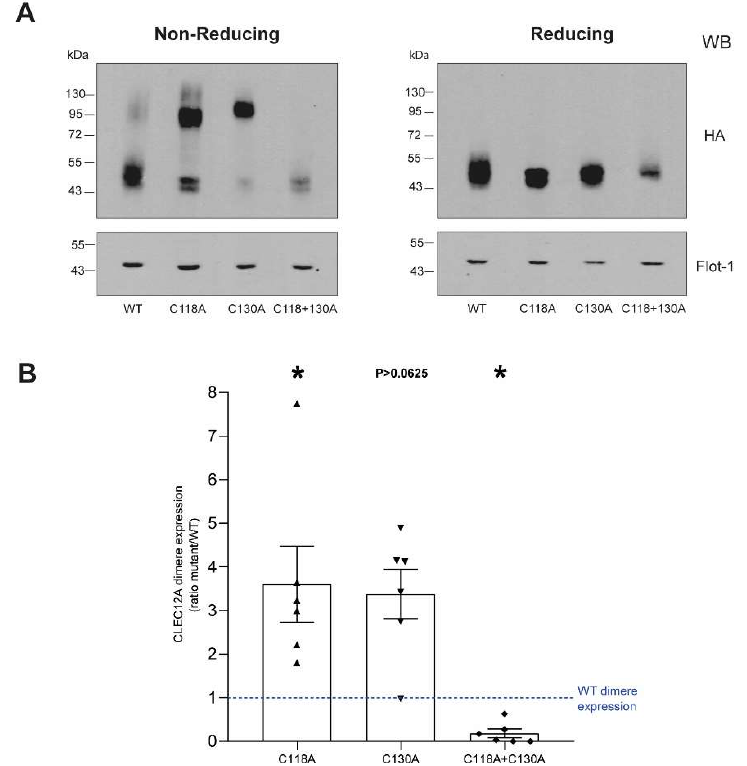
Figure 2. CLEC12A oligomerisation is dependent on C118 and C130. ( A ) Oligomerisation of WT CLEC12A and CLEC12A cysteine mutants was analyzed by Western blot of transiently transfected HEK-293T cells with the anti-HA and flotillin-1 antibody (loading control) under non-reducing (left blot) and reducing (right blot) conditions. ( B ) Densitometry analysis of CLEC12A oligomer expression in the non-reducing gel is shown as the following ratios: (CLEC12A mutant dimer/CLEC12A mutant dimer + monomer)/(CLEC12A WT dimer/CLEC12A WT dimer + monomer)’. The dotted line represents the CLEC12A WT ratio set to 1 for comparison with the CLEC12A mutants. Data in ( A ) are representative of six and three independent experiments for the non-reducing and reducing immunoblots, respectively. Statistical analysis: One sample Wilcoxon test * p < 0.05.